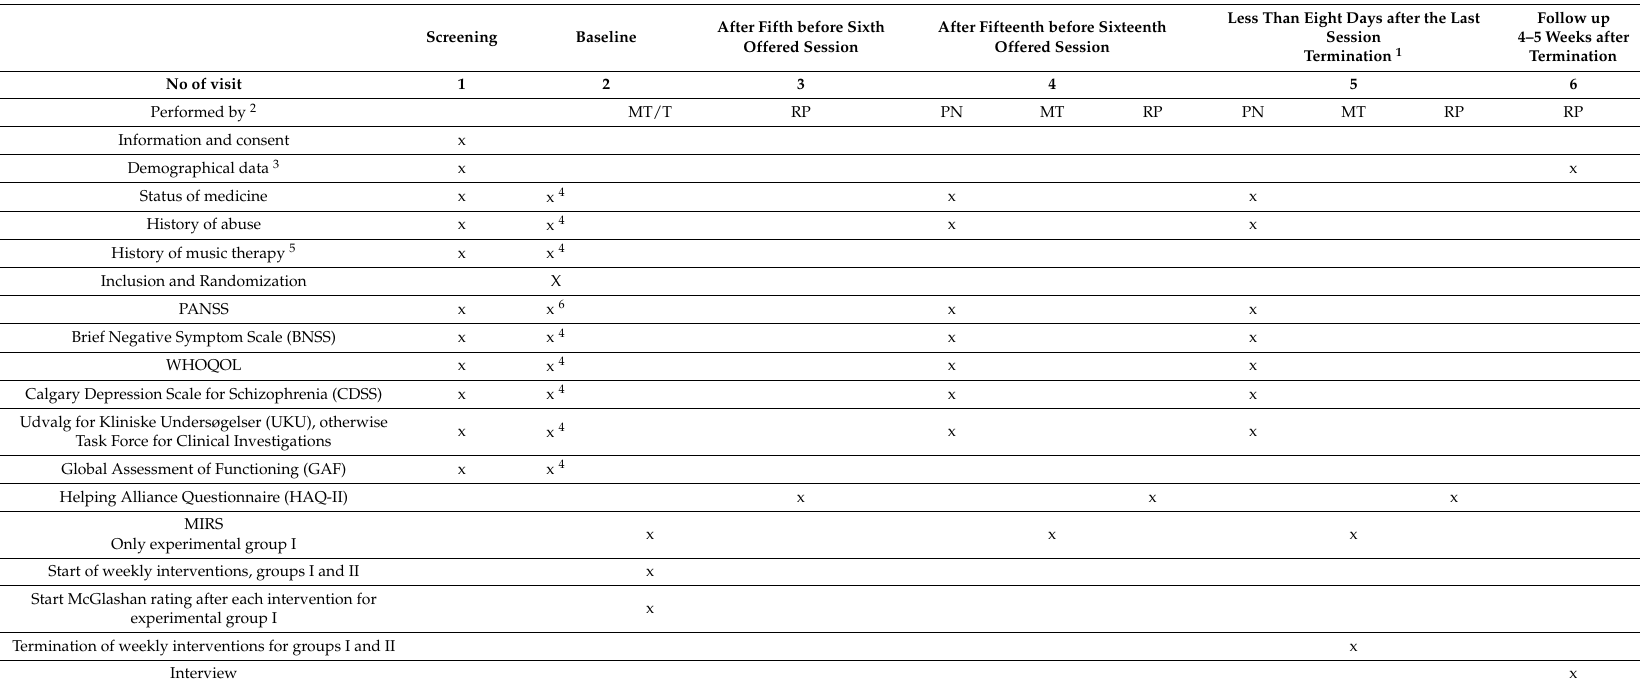
Table 1. A SPIRIT diagram on screening